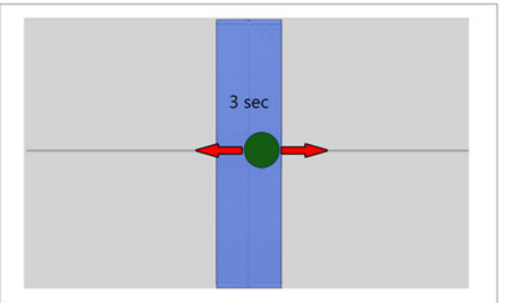
Fig 2. Visual Feedback. Feedback provided to each subject during the study. As the subject ’ s position shifted left or right, the green CoP marker shifted left or right. The green CoP marker ’ s vertical position was fixed. The blue rectangle represents the target region that the subject is attempting to reach with his/her CoP, while the time display indicates how long the CoP has remained within the target region. The arrows added to the figure indicate the directions of marker movement and were not part of the visual